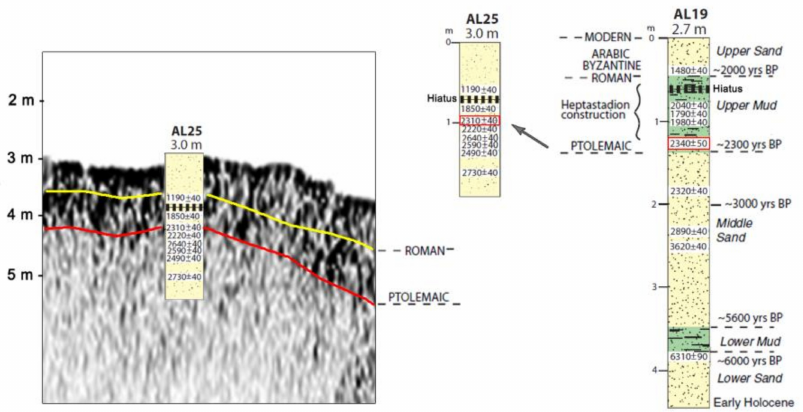
Figure 7. Core sample (AL25) tied with the SB profile (C) after correlation with core sample (AL19) (modified after Stanley et al., 2007 [7]).